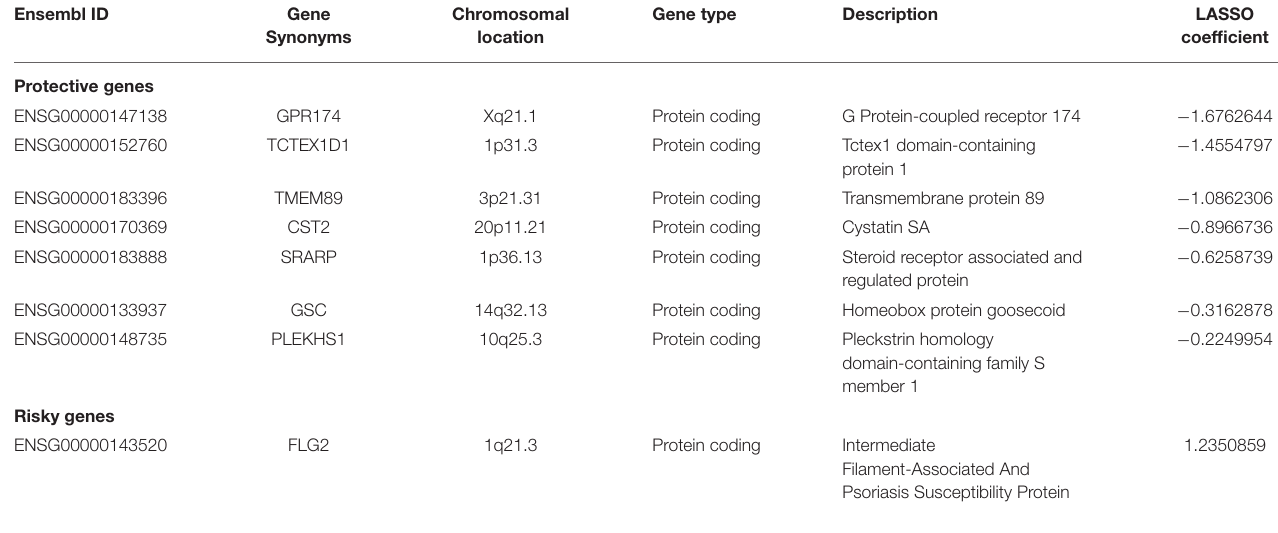
TABLE 2 | Information of the 8 genes in risk score model.